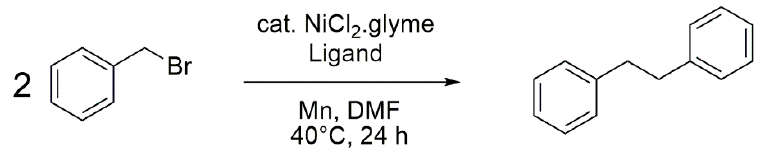
Scheme 2. Ni-catalyzed dimerization of benzyl bromide. Table 1. Yields obtained for the Ni-catalyzed dimerization of benzyl bromide with 4,4 ′ ,4 ″ -tritertbutyl- 2,2 ′ :6 ′ ,2 ″ -terpyridine and compound 1 as ligands.